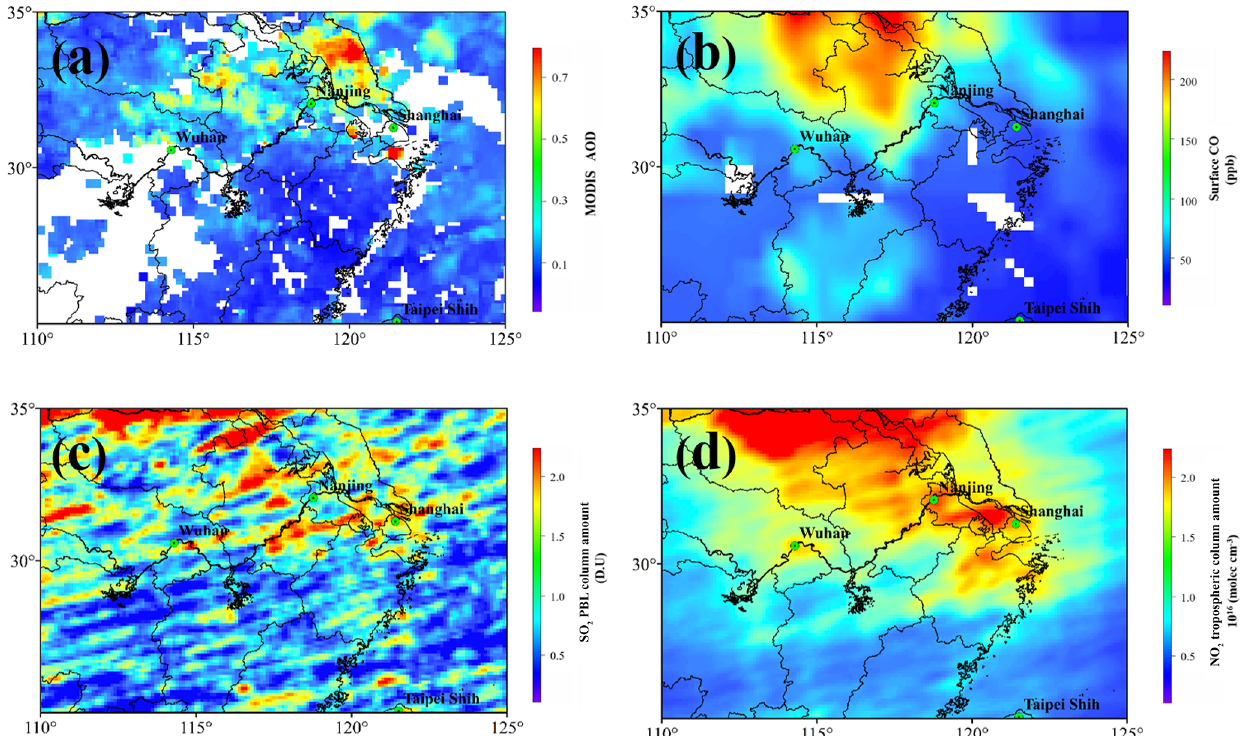
Figure 2. The average distribution of (a) aerosol optical depth at 550nm (MODIS L2); (b) CO column mixture ratio (MOPITT L2); (c) the SO 2 column concentration (OMI L2); (d) the NO 2 column concentration (OMI L2) over the MLYR